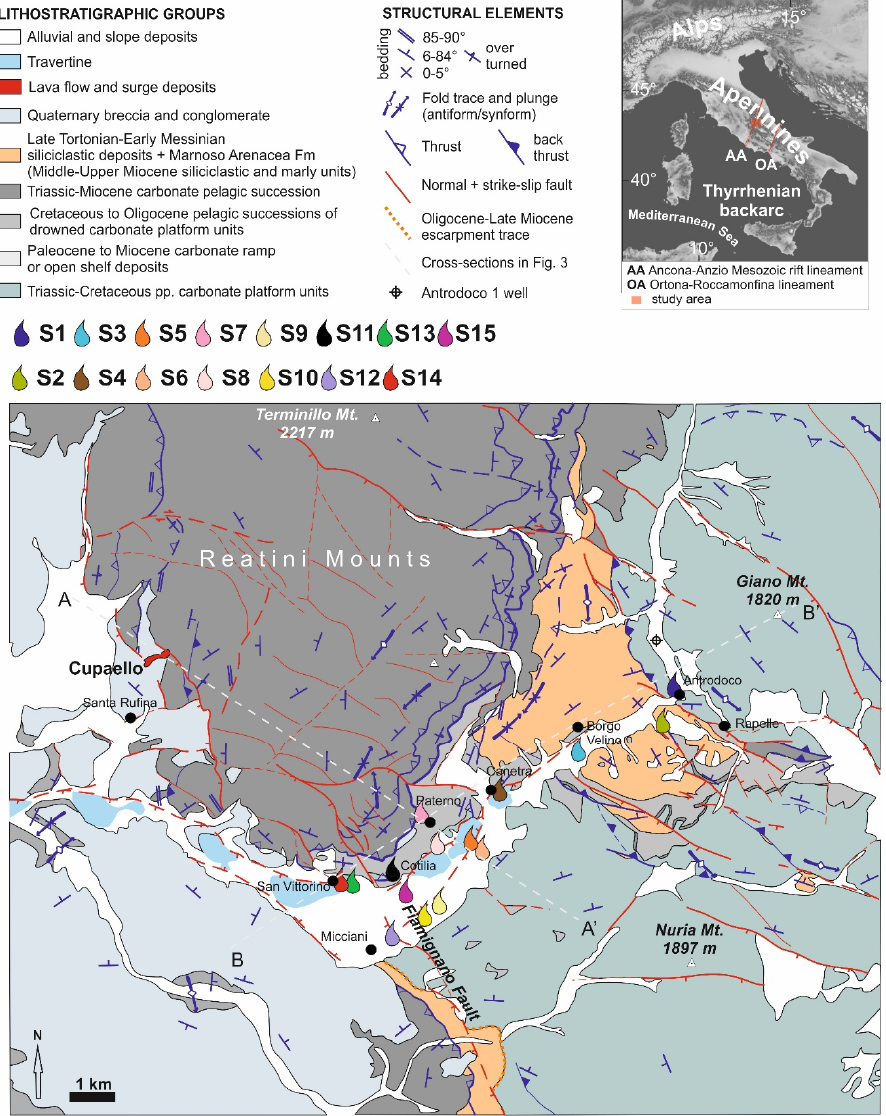
Figure 1 . Simplified tectonic map of the study area modified after the compared review of Foglio “L’Aquila” and “Rieti” (https://www.isprambiente.gov.it/) [40,49,50,54,55]. The map shows the location of the selected springs.